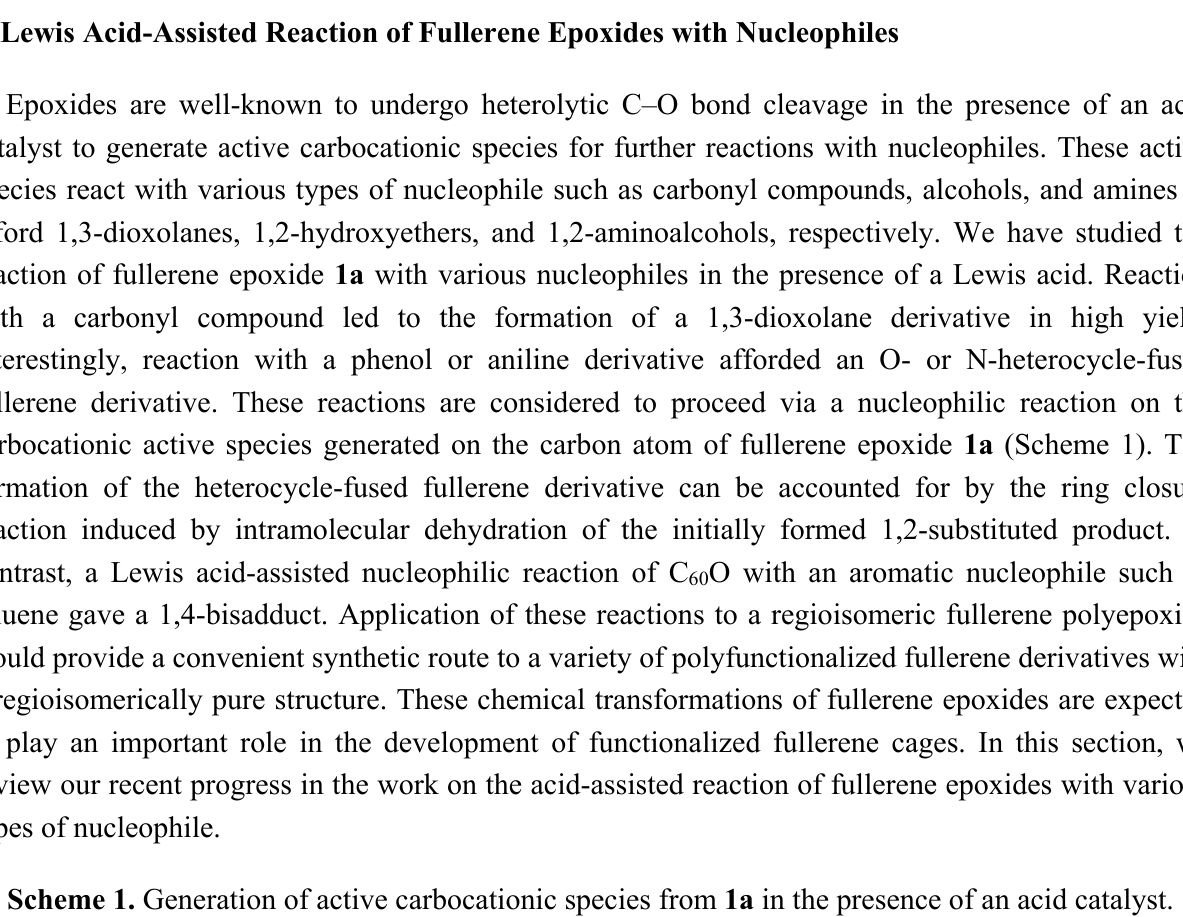
Figure 3. Fullerene mono-epoxide and regioisomeric di-epoxides isolated by means of preparative HPLC from a mixture of C